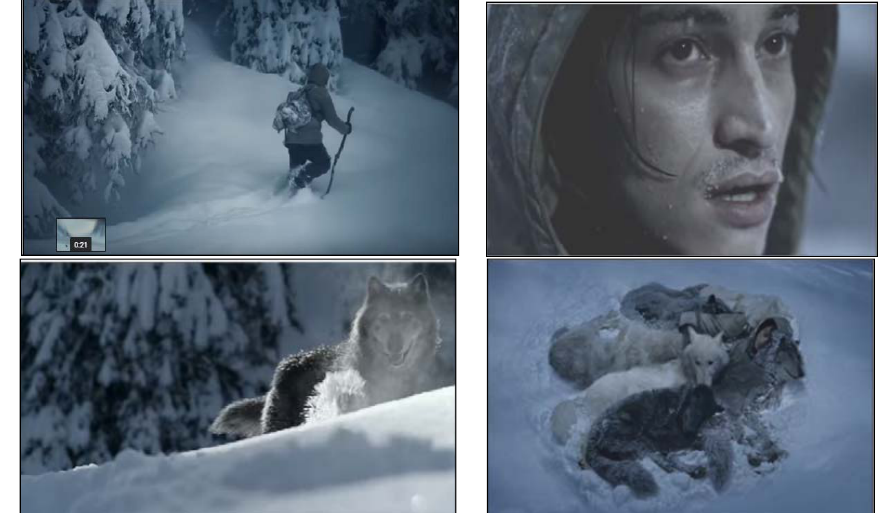
Figure 3. Screenshot TV commercial SL.